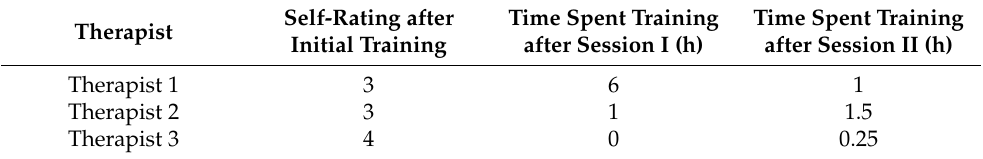
Table 2. Survey results and time spent training by each therapist outside of training session delivered by study